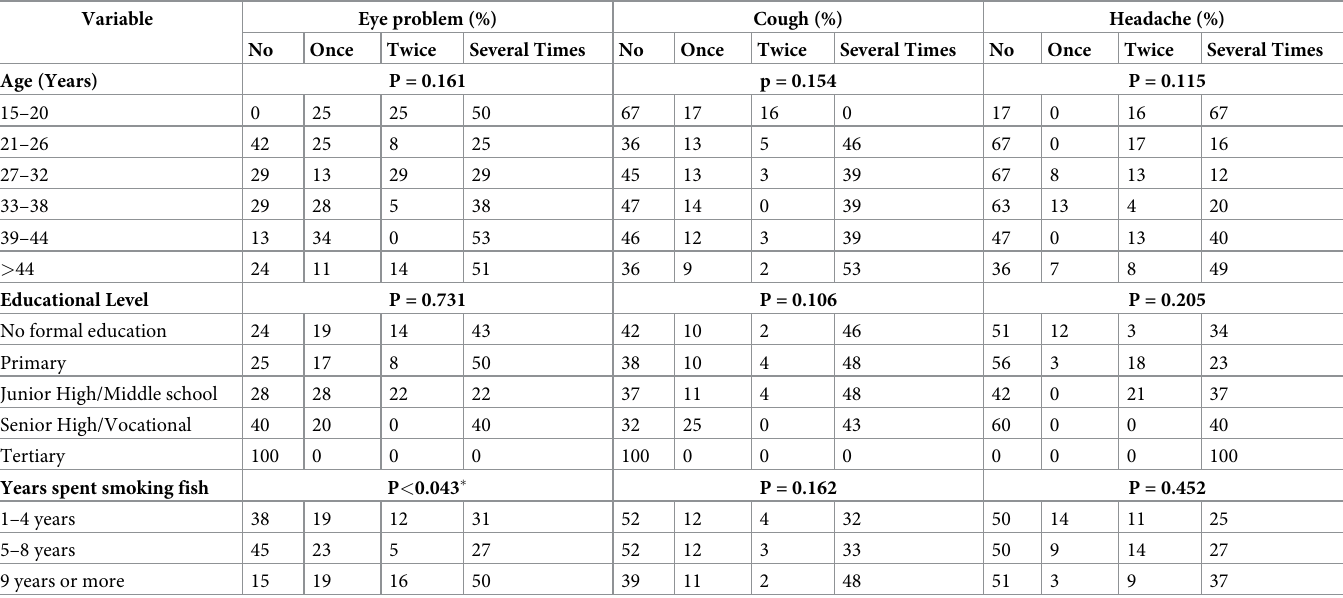
Table 4. Identified fish smoking-related health symptoms.